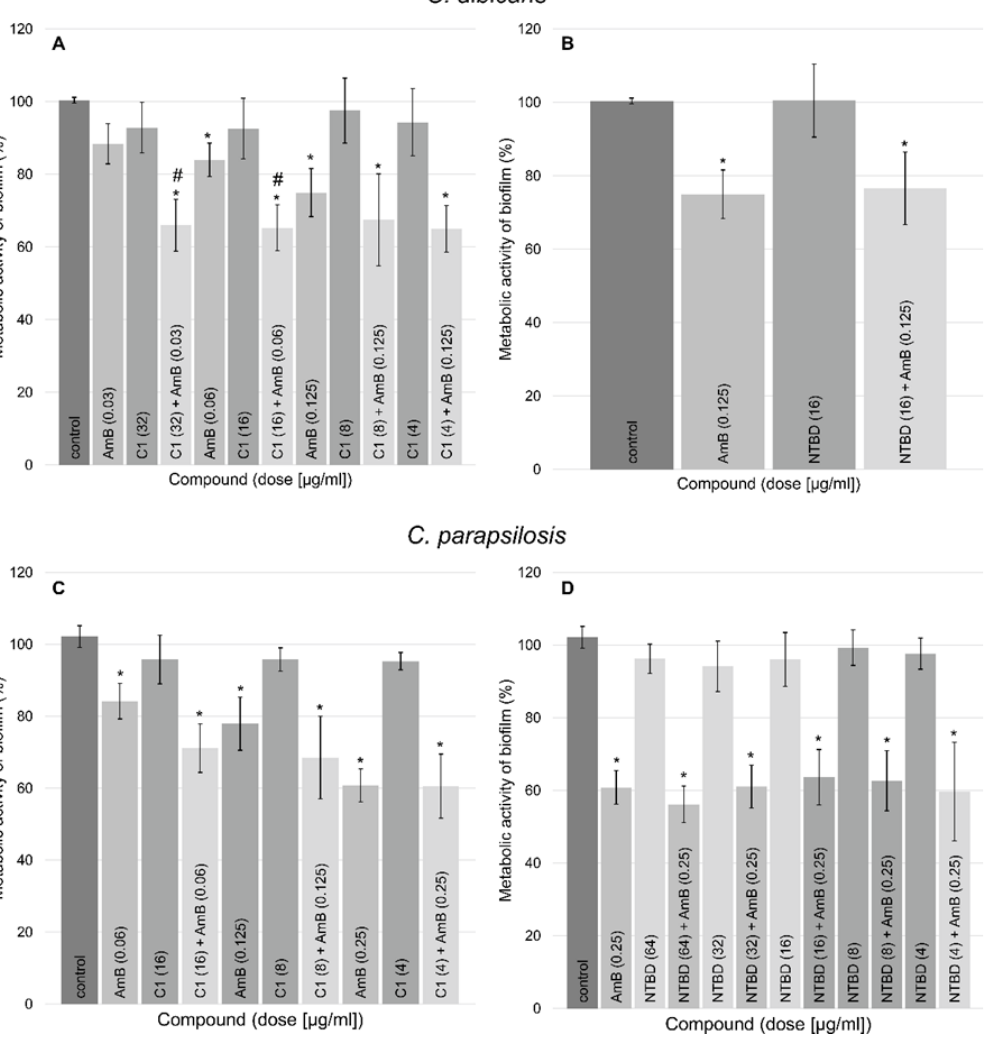
Figure 4. The MTT assay results presenting the analyzed compounds and combinations